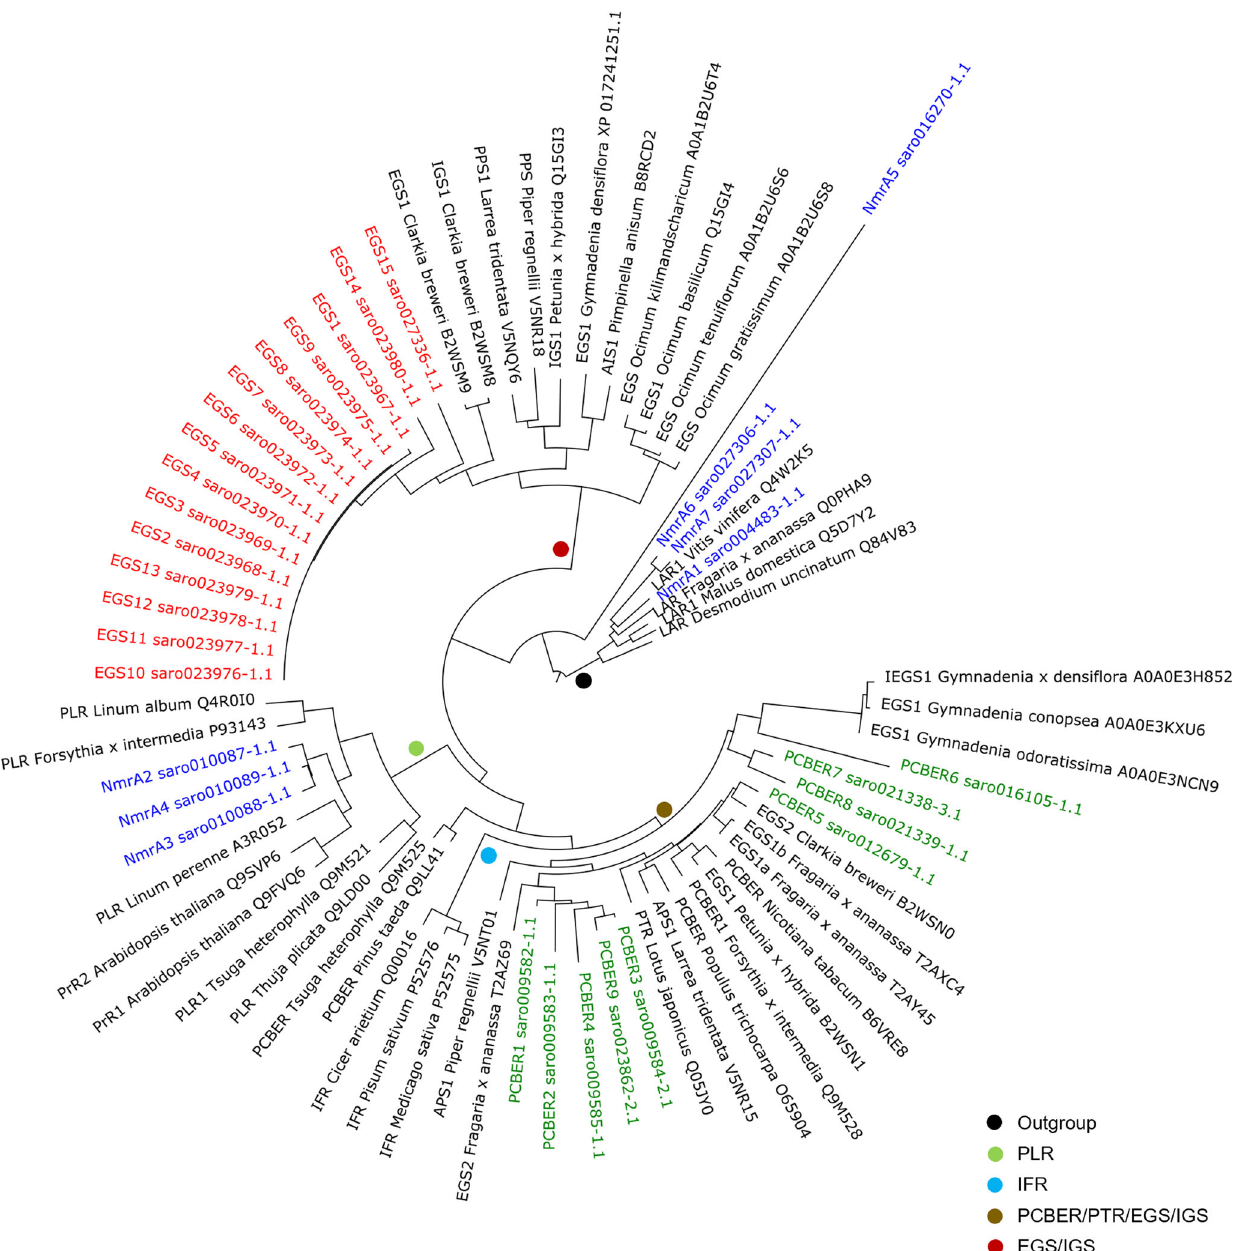
Fig. 4 Evolution of selected putative members of the PIP family in Syzygium aromaticum . Phylogenetic tree of protein sequences from the PIP family and S. aromaticum putative EGS, PCBERs, and proteins containing a NmrA domain possibly involved in the biosynthesis of eugenol. The phylogenetic trees were generated by using Clustal Omega. Groups from Koeduka 25 . EGS eugenol synthase, IGS isoeugenol synthase, AIS anol/isoeugenol synthase, PPS propenyl- phenylpropene synthase, APS allyl-phenylpropene synthase, PTR pterocarpan reductase, PCBER phenylcoumaran benzylic ether reductase, IFR iso fl avone reductase, LAR leucoanthocyanidin reductase, PLR pinoresinol – lariciresinol reductase, PrR pinoresinol